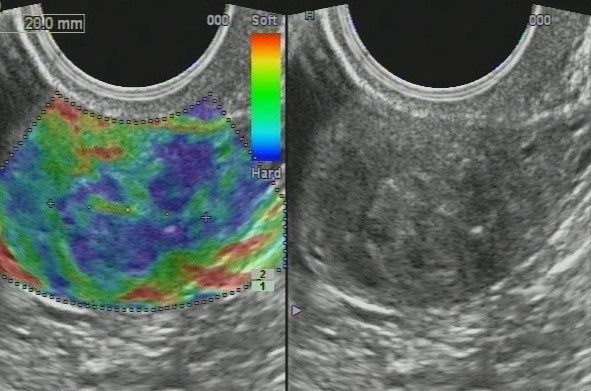
Changing the amount of TGF-β1 in serum of patients with the cervical precancerous diseases. In cervical specimen of HPV DNA with low- and medium-avidity and IgG antibodies to HSV-1 and/or HSV-2 (data are presented as M ± Std. Dev). 1, control group (clinically healthy women); 2, patients with low-avidity IgG antibodies to HSV-1 and/or HSV-2; 3, patients with medium-avidity IgG antibodies to HSV-1 and/or HSV-2.